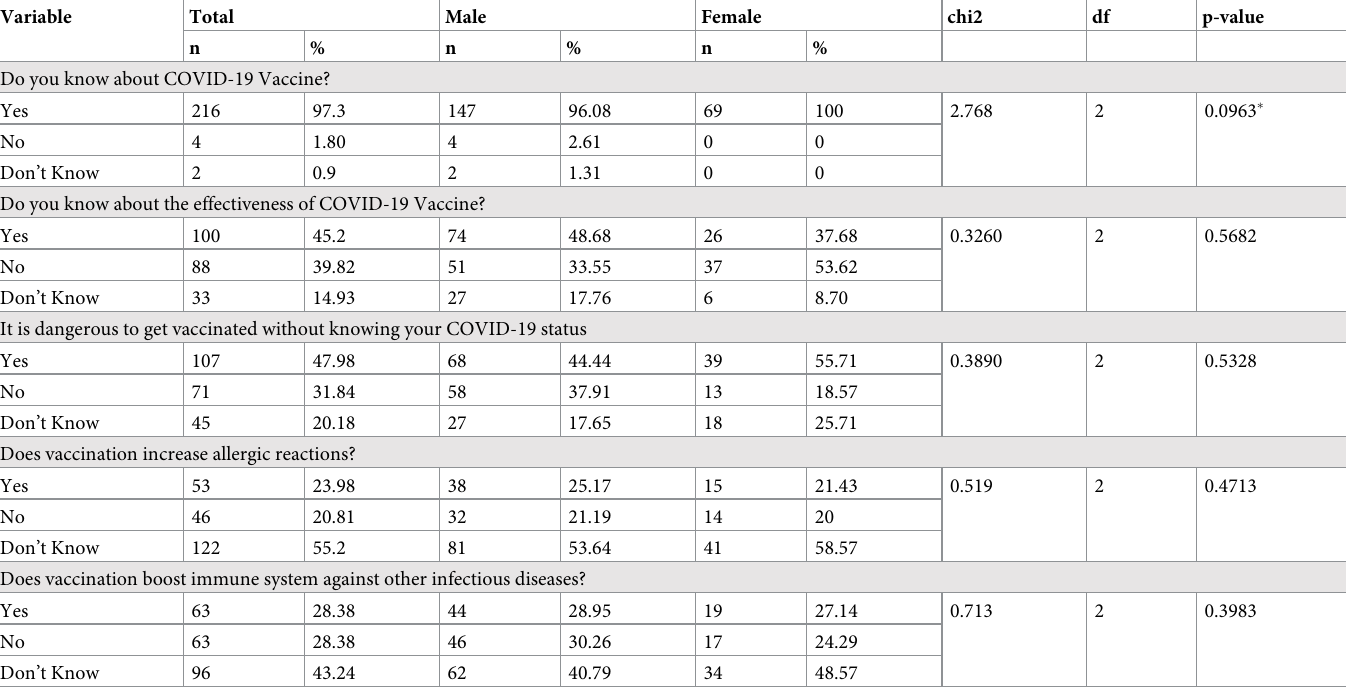
Table 2. Distribution of each knowledge item by gender